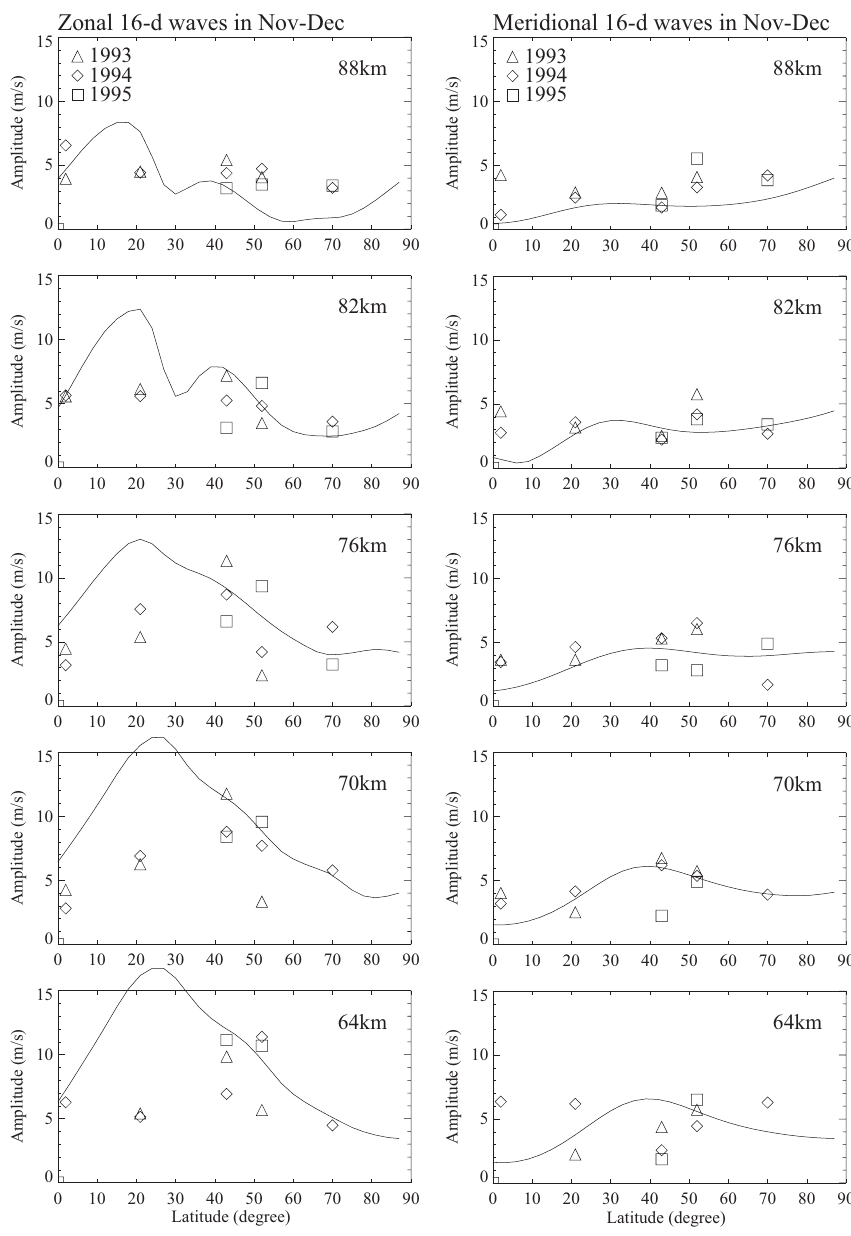
Fig. 8. The latitudinal variations of the 16-day wave amplitudes from radar observations and the GSWM. The scattering points are spec- tral amplitudes using available data of November/December of years 1993, 1994 and 1995 (denoted by triangles, diamonds and squares, respectively) at five radar locations and selected altitudes. The continuous lines are wave amplitudes from the